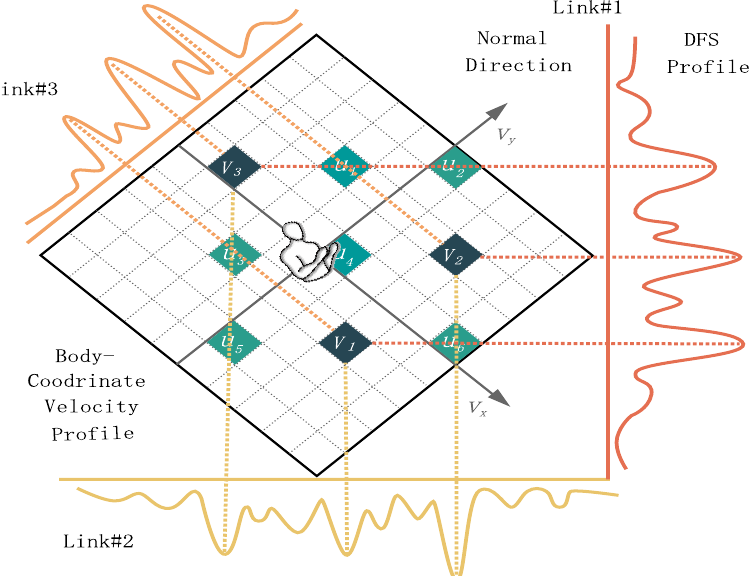
Figure 5. The velocity components of human torso profiles are projected on frequency components to realize the mapping between velocity and signal power, which is the relationship between BVP and